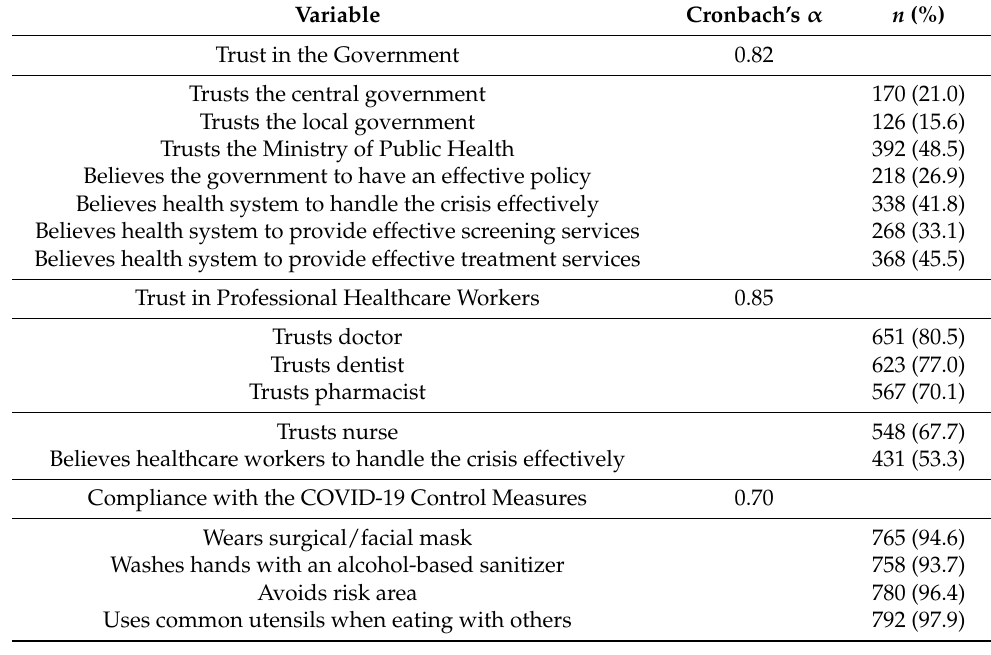
Table 2. Descriptive statistics for variables used in the study ( n = 809).